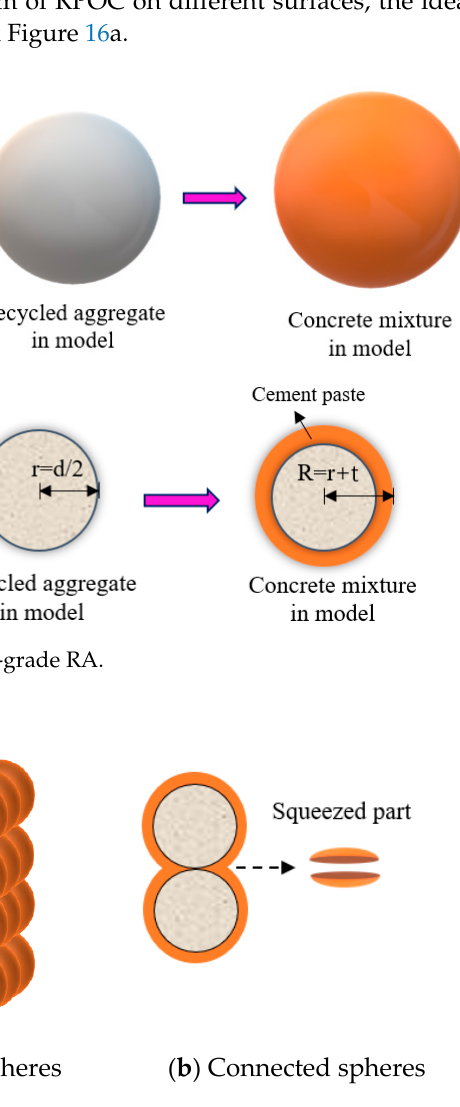
Figure 16. Structural model of RPOC. Since the compressive damage of POC with low-grade RA mostly occurs at the bond- ing area between aggregates, it is assumed that the fracture surface is the weakest part of the bonding area, as shown in Figure 17. It can be seen that the fracture area is equal to the bonding area between aggregates, which is defined as the effective fracture area. Therefore, the relationship between compressive strength and aggregate bonding area is established. In the numerical calculation, the effective fracture area of a single aggregate is equal to the bottom area of the squeezed part, which can be calculated by the spherical crown formula, as shown in Equations (6) and (7). A = π ( (cid:1872) (cid:2870) +2 tr )